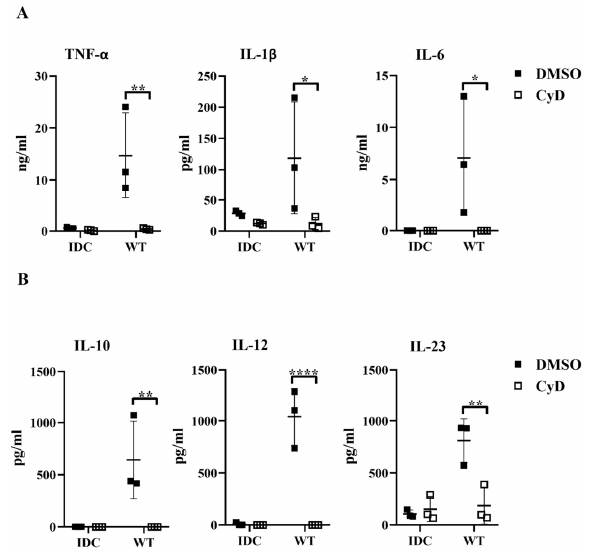
Figure 8. Blocked phagocytosis leads to reduced cytokine secretion by bacteria-exposed moDCs. Five-day moDCs were preincubated with 15 µ M CyD or the vehicle control DMSO for 30 min. Then, moDCs were stimulated with WT L. casei at a ratio of 1:4 for 24 h. IDC means cells without bacterial treatment. The concentrations of proinflammatory TNF- α , IL-1 β , and IL-6 cytokines ( A ) and the T-cell-polarizing IL-10, IL-12, and IL-23 ( B ) were determined from the supernatants of the WT-bacteria-activated moDCs and control IDCs. Figures represent the mean of 3 independent donors ± SD. Each dot represents one donor. The Student’s paired two-tailed t -test was used in the statistical analysis, with significance defined as * p < 0.05, ** p < 0.01, and **** p < 0.0001 between the CyD- and DMSO-treated